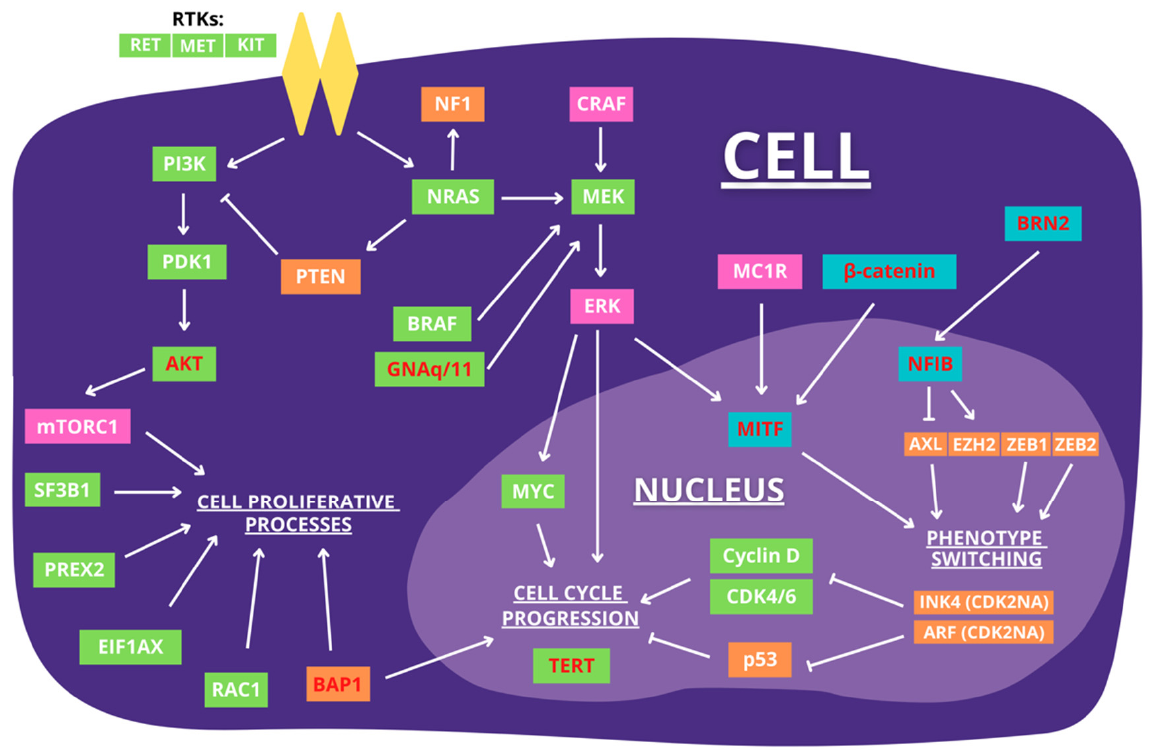
Figure 1. Illustration of pathway components involved in melanoma progression. Orange indicates the protein is silenced, green indicates upregulation, and pink indicates upregulation or downregulation during progression. Gene written in red are implicated to have importance in melanoma metastasis.